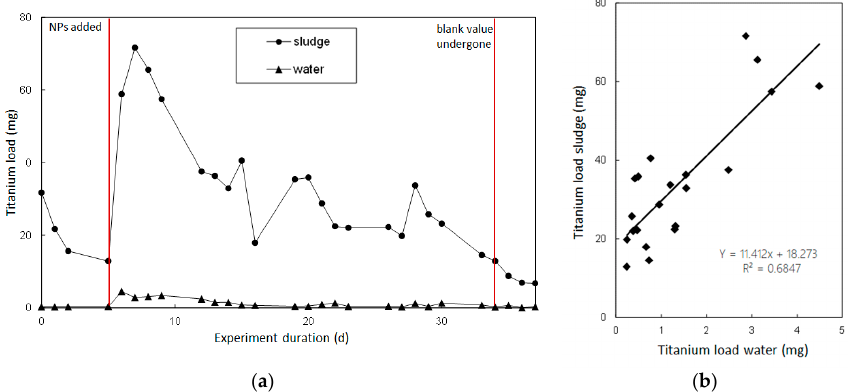
Figure 3. Discharge loads of titanium nanoparticles (NP) after single particle addition on test day 5. ( a ) Titanium load over experiment duration, ( b ) correlation between titanium load in water and sludge.